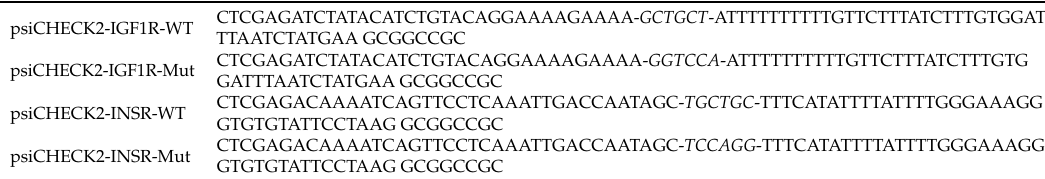
Table 1. The 3 (cid:48) -untranslated region (3 (cid:48) -UTR) sequences that was cloned into